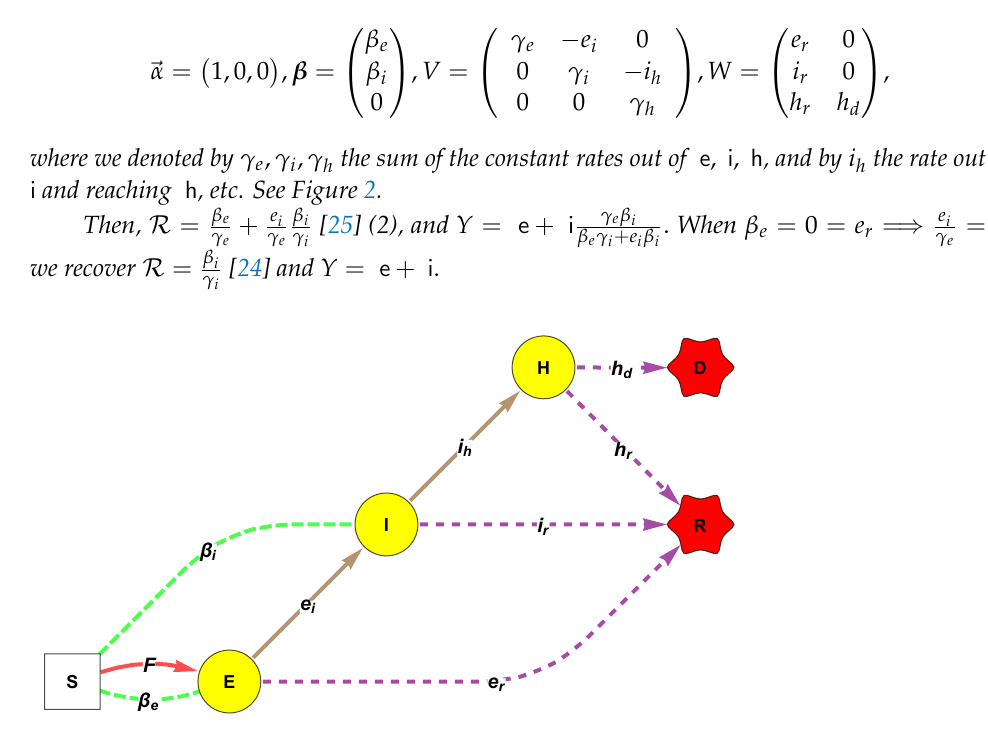
Figure 2. Flowchart of the SEIHRD model. The forces of infection are F se = β e e , F si = β i i , F = F se + F si . The red edge corresponds to the entrance of susceptibles into the diseased classes; (cid:126) α , the dashed green edges correspond to contacts between diseased to susceptibles, the brown edges are the rates of the transition matrix V , and the remaining yellow dashed flows correspond to the rates of W